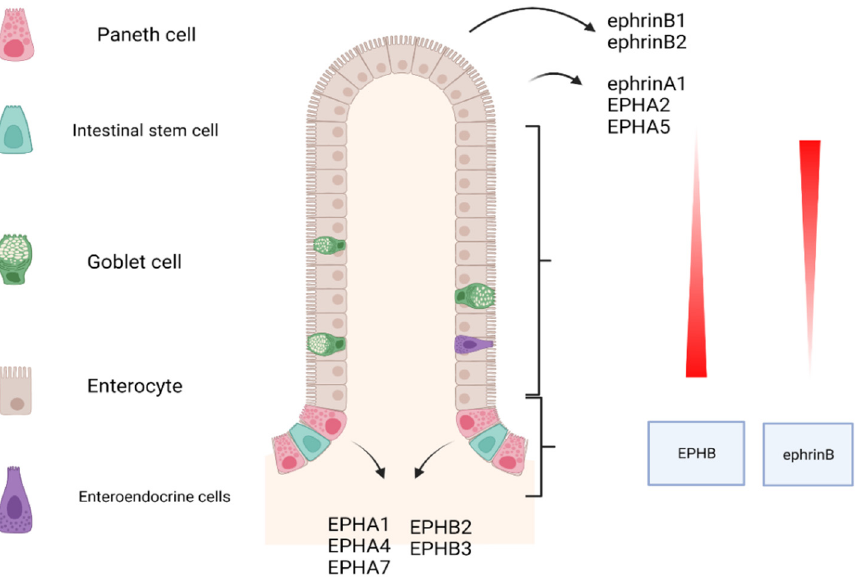
Figure 1. EPH/ephrin expression gradient in gastrointestinal tract. Black arrows: the points of maximal expression. Created with BioRender.com, accessed on 20 February